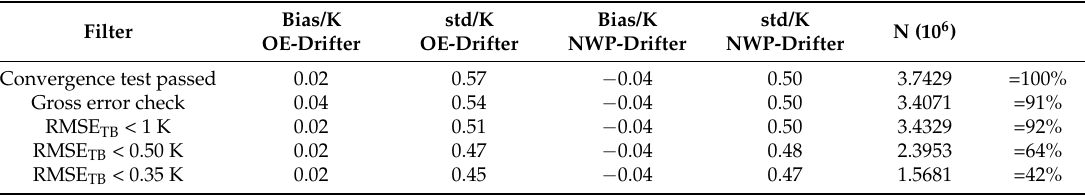
Table 3. Comparison of retrieved SSTs and NWP SSTs against drifter SSTs for various subsets.